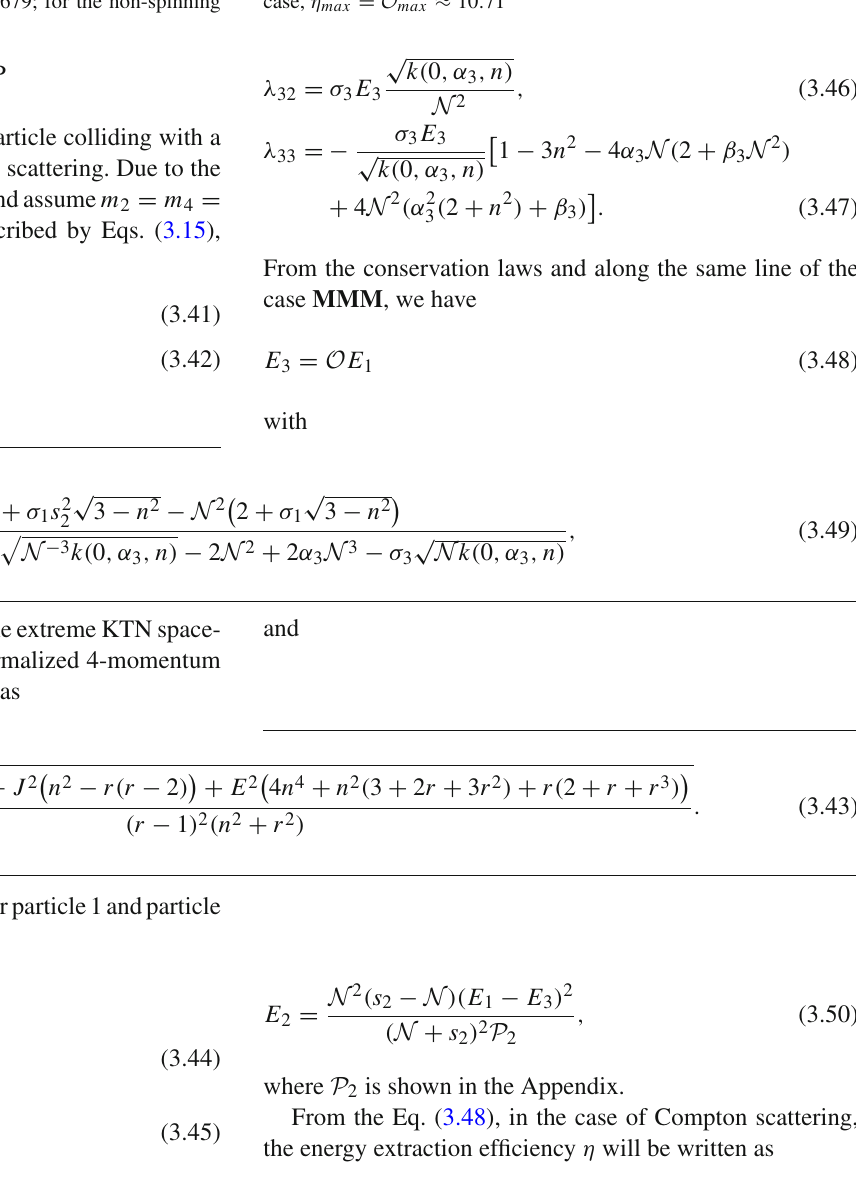
case, η max = O max ≈ 13 . 93. b When n = 0 . 3, for the spinning case, η = O ≈ 19 . 4799 with s ≈ − 0 . 2623; for the non-spinning max max 2 case, η max = O max ≈ 12 . 60. ( c ) When n = 0 . 5, for the spinning case, η = O ≈ 13 . 3427 with s ≈ − 0 . 2433; for the non-spinning max max 2 case, η max = O max ≈ 10 .